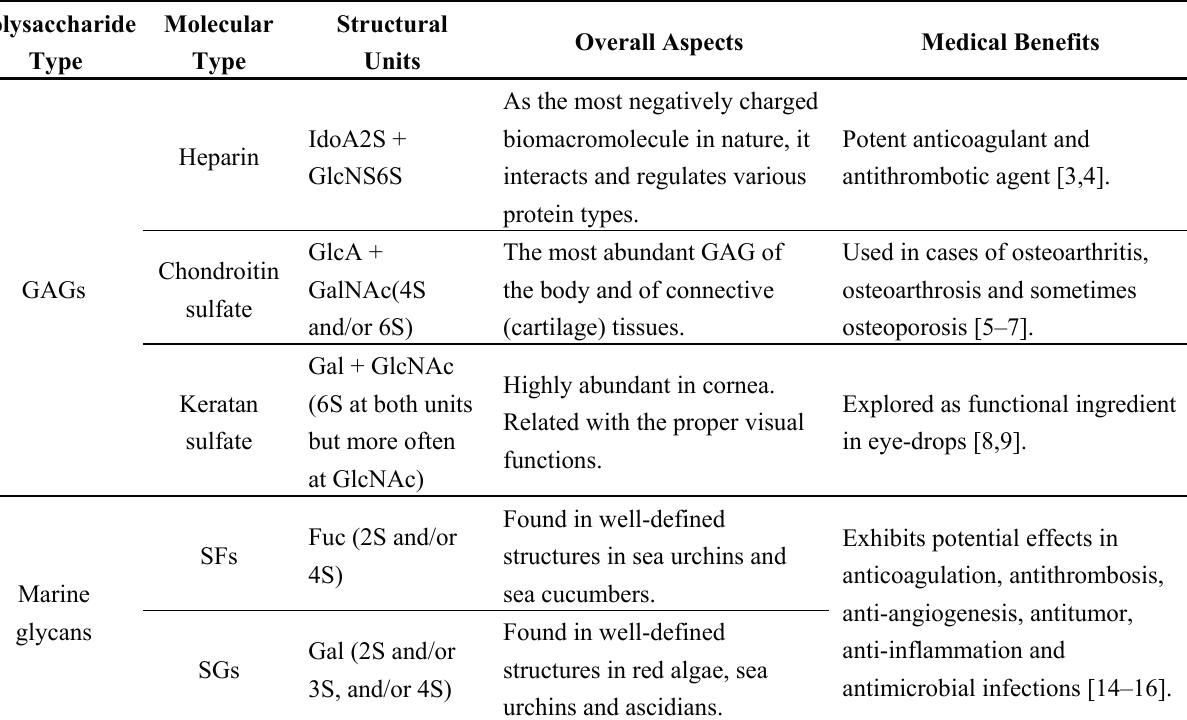
Table 1. Comparative structural and medical aspects of glycosaminoglycans (GAGs) and marine sulfated glycans of well-defined chemical